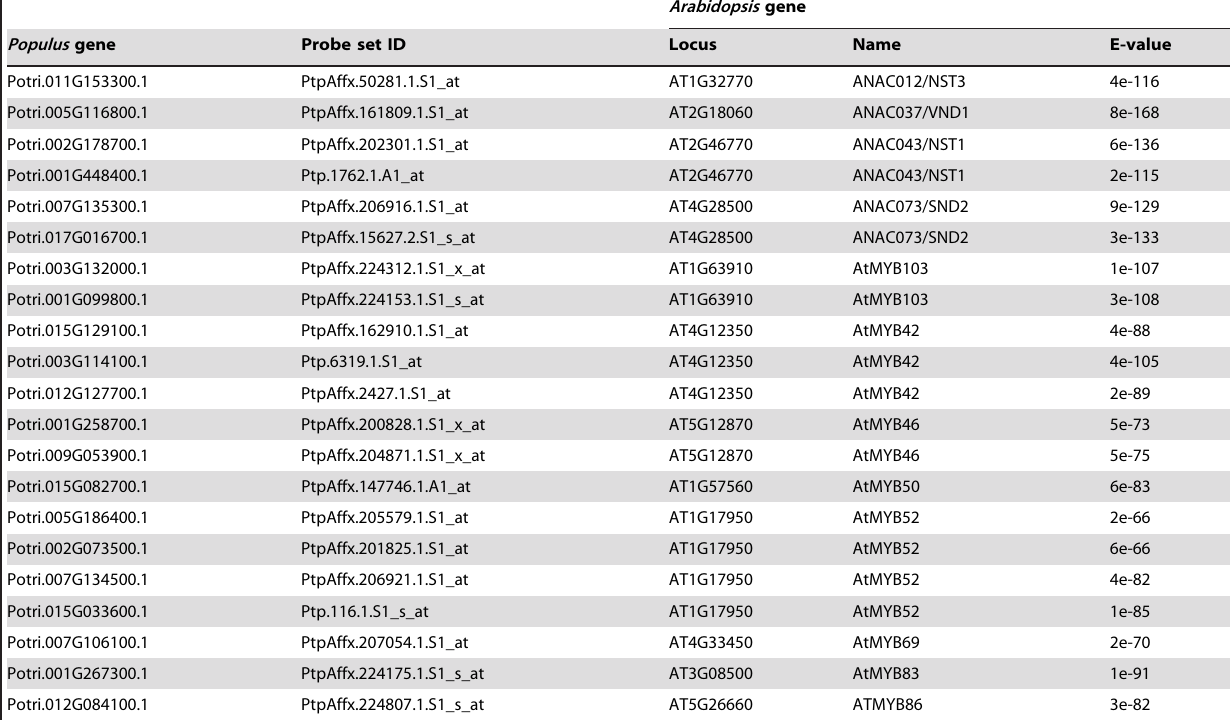
Table 1. Populus transcription factors in Module